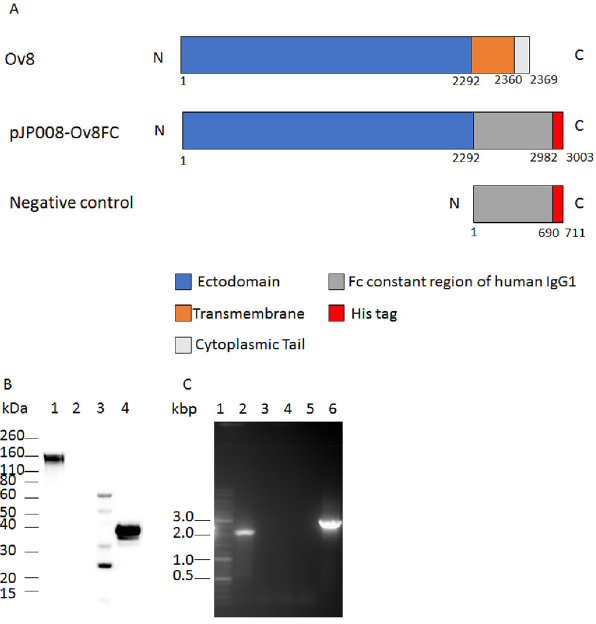
Fig 1. Ov8FC schematic representation and expression. (A) Schematic representation of full length Ov8 (Ov8), truncated Ov8 with Fc region of human IgG1 and His-tag (Ov8FC), and the Fc region of human IgG1 only with His- tag (hIgGFC, Negative control). Numbers below constructs indicate amino acids. (B) Western blot analysis of supernatant from 293-T cells transfected with pJP008-Ov8FC (Lane 1), pJP008 empty plasmid (Lane 2), protein markers (Lane 3) and pJP008-hIgGFC (Lane 4) using mouse monoclonal anti-His antibody. Molecular masses are indicated on the left in kilodalton (kDa). (C) Reverse transcription PCR of cells transfected with pJP008-Ov8FC with and without reverse transcriptase, respectively (Lanes 2 and 3) and pJP008 empty plasmid with and without reverse transcriptase, respectively (Lanes 4 and 5). Control PCR of pJP008-Ov8FC plasmid (Lane 6). DNA marker in kilo base pairs (Lane